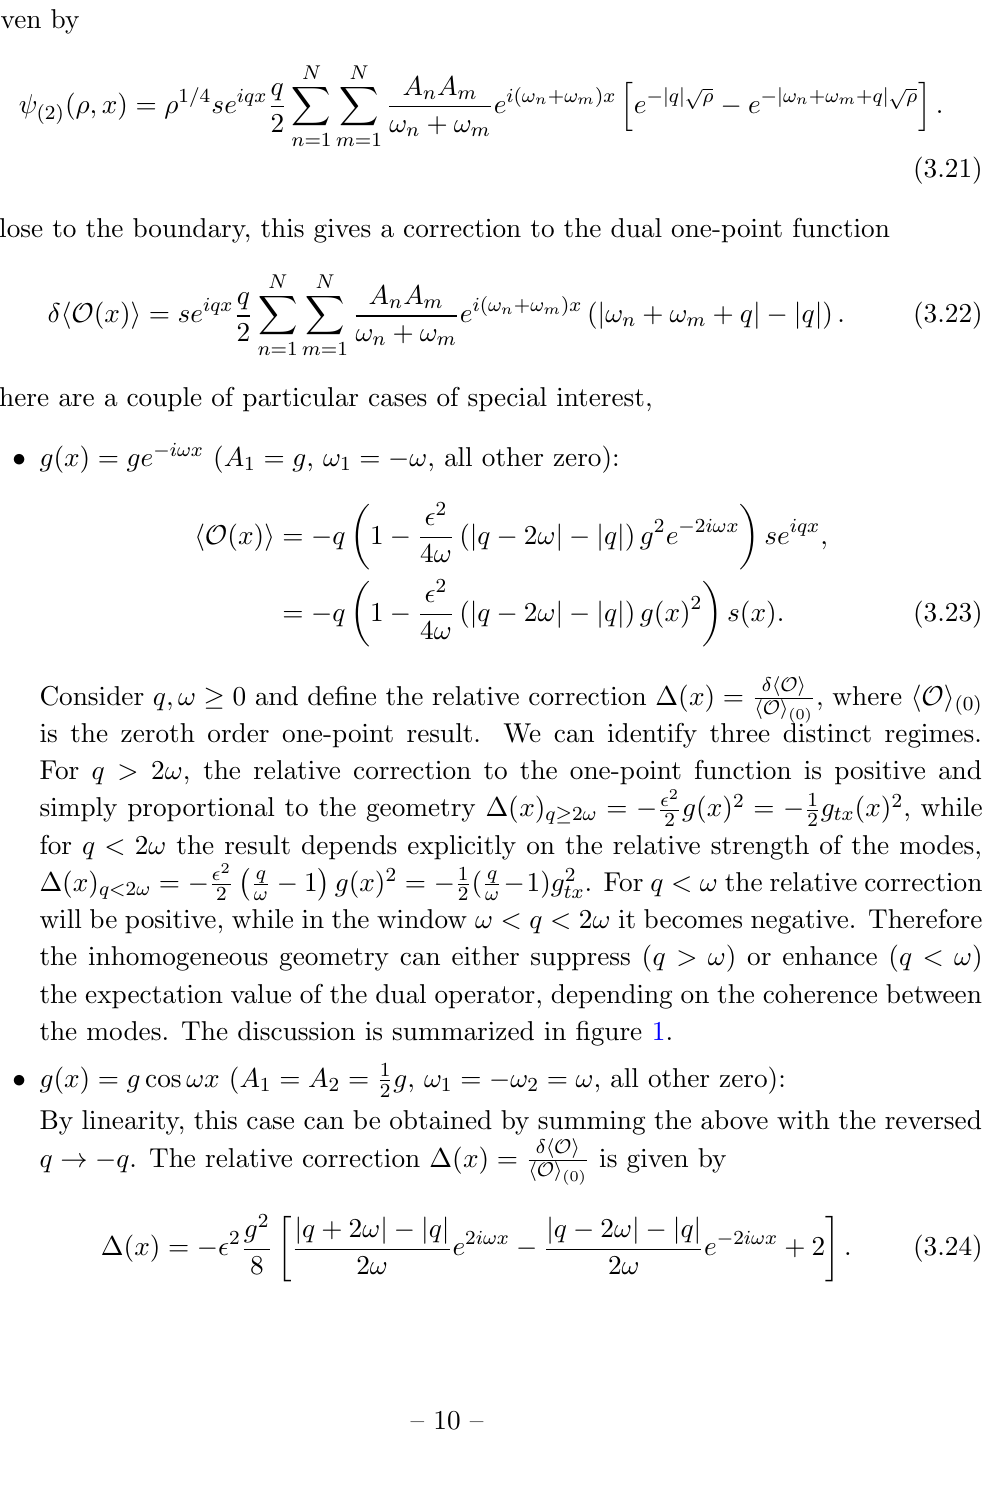
Figure 1 . Sign of the relative correction (cid:1)( x ) for di(cid:11)erent q (cid:21) 0 and (cid:12)xed ! . Constant source Let s ( x ) = s be a constant, i.e. s = (cid:14) ( k ). As before, the above integral k trivially gives = 0. There are no corrections to the boundary dual operator. (2) Plane wave source Let s ( x ) = se iqx , i.e. s = s(cid:14) ( k (cid:0) q ). The Fourier transform k